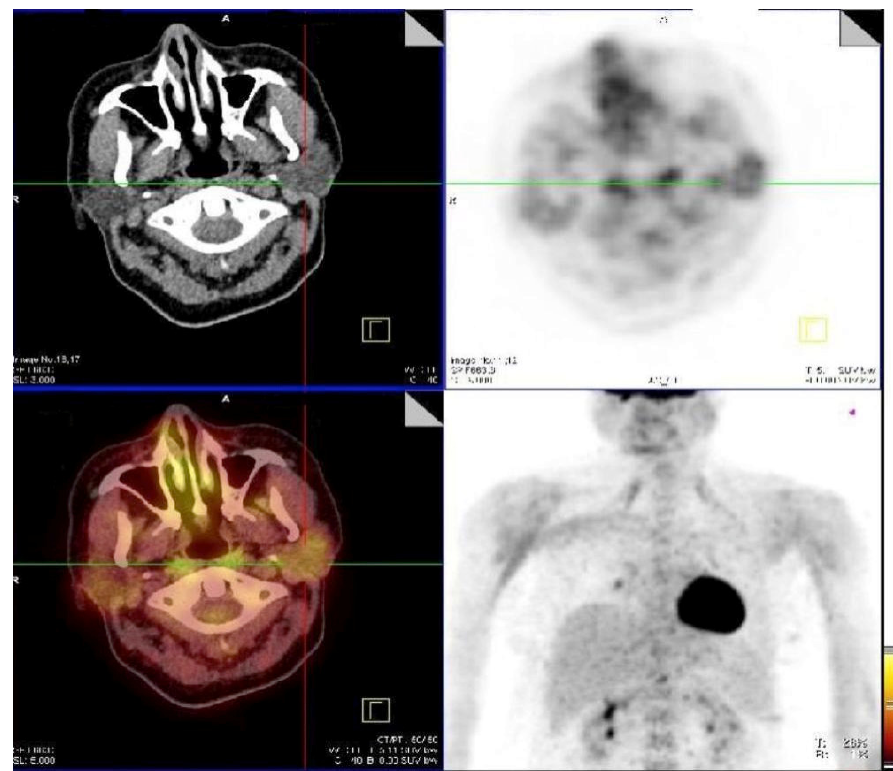
Figure 1. Active sarcoidosis present in submandibular glands, right supraclavicular lymph node, right hylar lymph node. J. Clin. Med. 2019 , 8 , 803